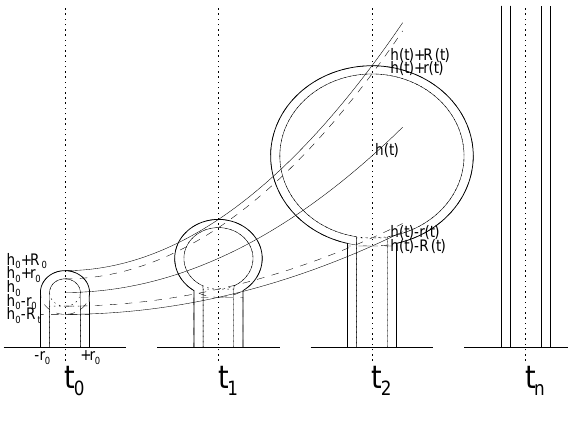
Fig. 1. The definition of the self-similar geometry of the CME model is depicted for four different times, consisting of a cyclidrical base and a spherical shell. The height of the centroid of the spher- ical CME volume is h(t) , the outer radius of the CME sphere is R(t) , and the inner radius of the CME front is r(t) . These param- eters increase quadratically with time. The circular footpoint area of the CME with radius r 0 stays invariant during the self-similar expansion in order to satisfy the line-tying condition of the coronal magnetic field at the